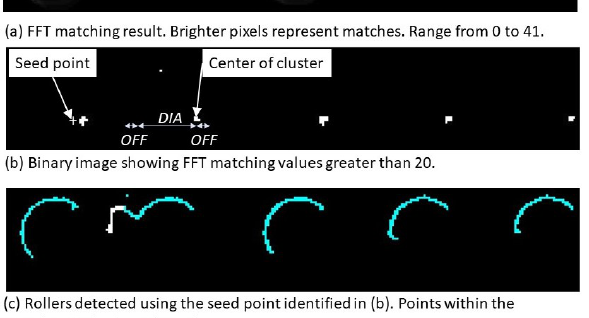
Figure 11. FFT matching between the template and the data image.